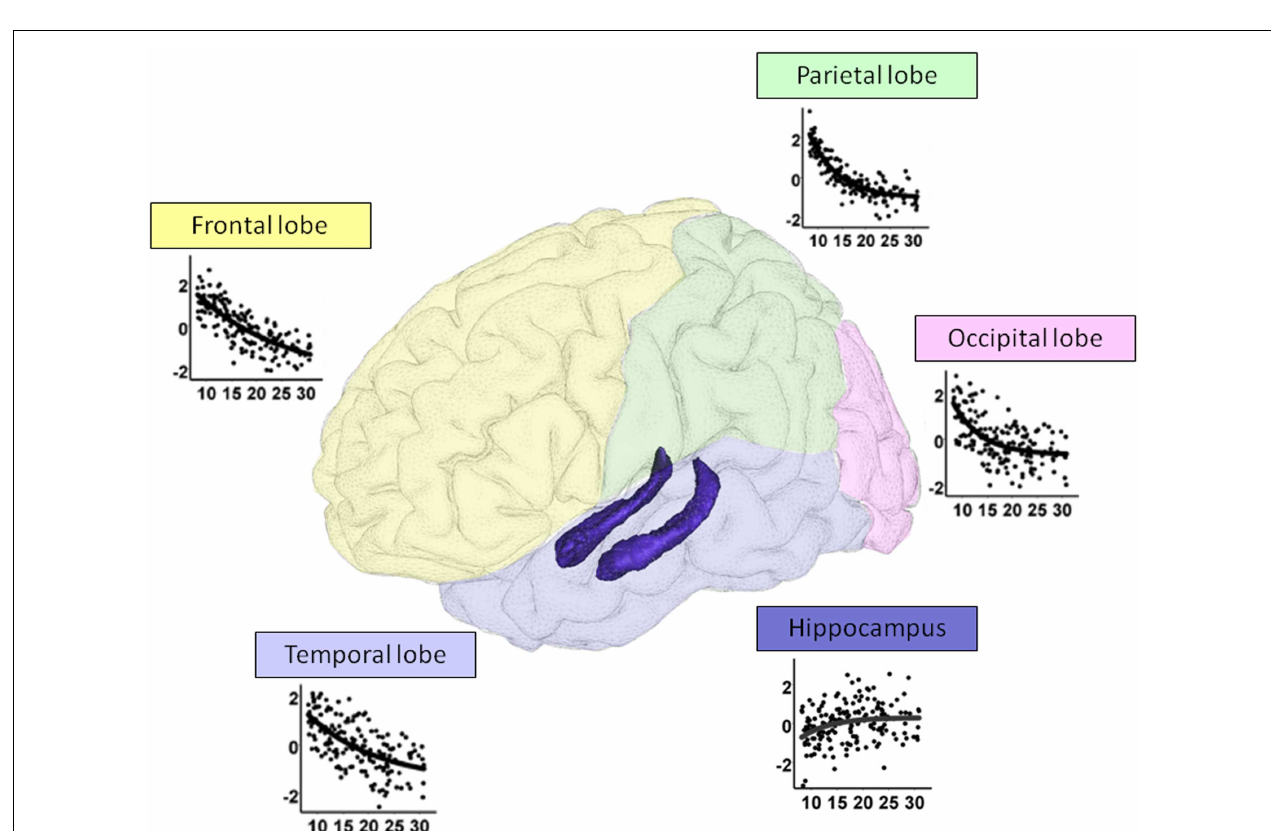
The non-linear decrease in cortical lobe volume contrasts with a slight increase in hippocampal volume. Parietal and occipital lobe seem to mature earlier than temporal and frontal lobes. Adapted from Ostby et al.